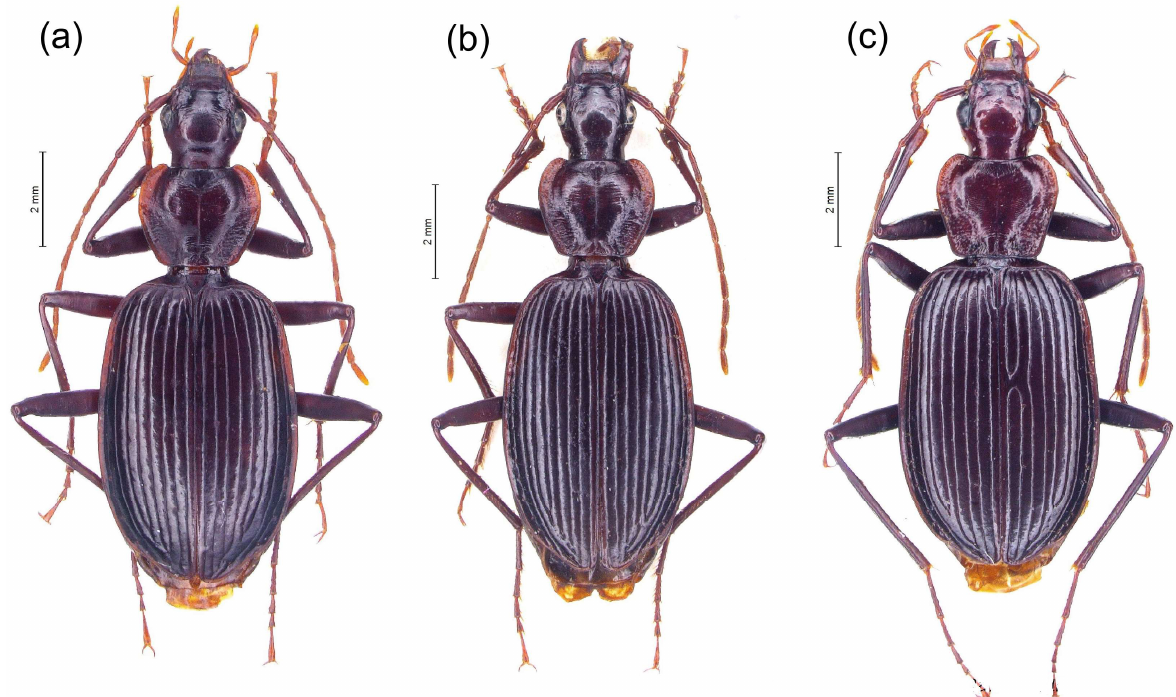
Figure 15. Habitus of Platynus species: ( a ) P. occitanus n. sp .; ( b ) P. peirolerii ; ( c ) P. maritimus n. sp.